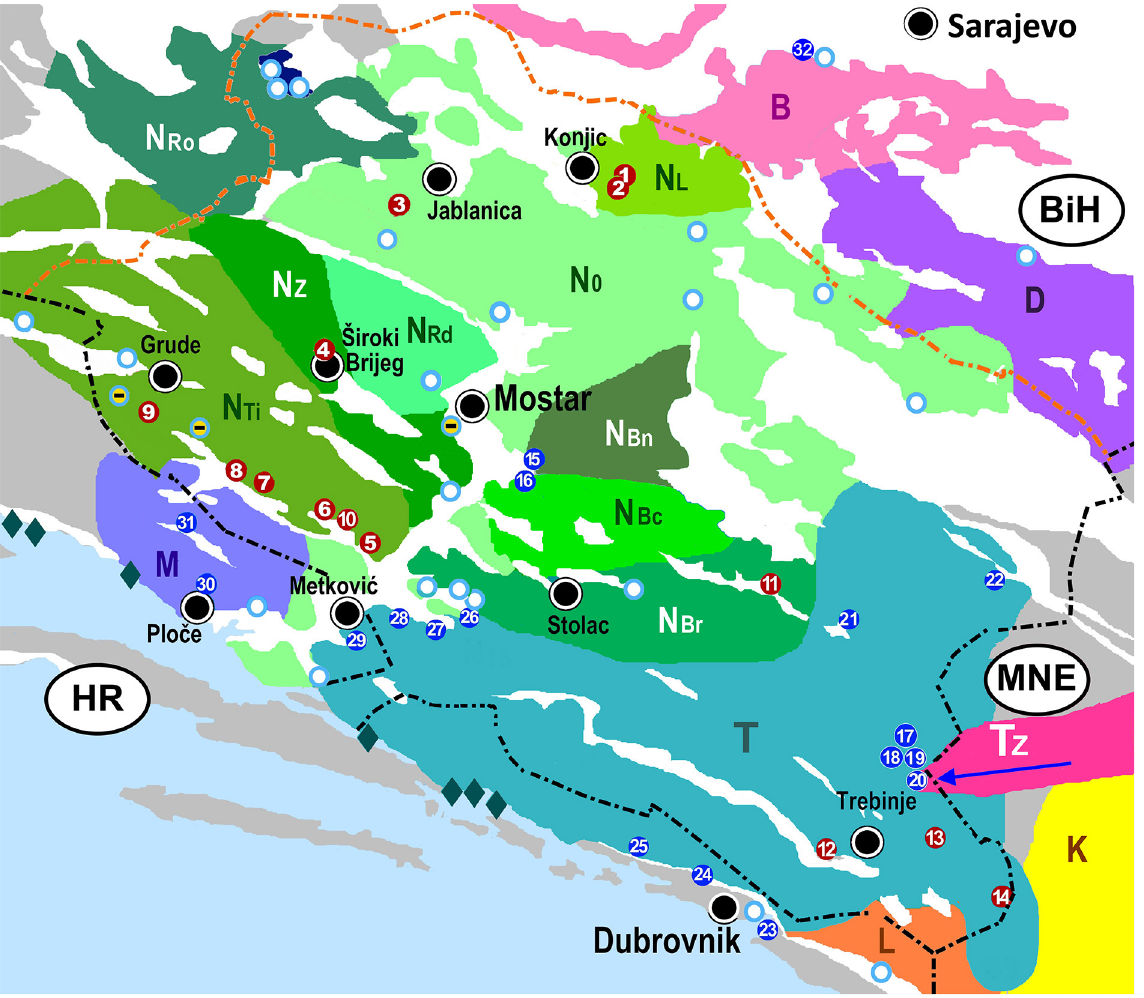
Fig. 17. Karst aquifers of Hercegovina and their estimated delimitations to drainage basins. As most to the karst aquifers in Hercegovina are represented by subterranean karst conduits, it is difficult to exactly set the watersheds. The subterranean drainage divides in this map were estimated based on our recent knowledge about the geology, hydrogeology and geomorphology. The boundaries are unstable and strongly dependent on a dynamic system of particular water level alternations in each perched water table within the basin as well as on their particular saturation. The interim oversaturation in the particular basin could lead to water divergence to the neighbouring river basin. The supposed inter-basin water divergences at high water saturation are highlighted by blue arrows. Each drainage basin could be further divided to separate subterranean karst conduits, which could also represent a kind of particularly isolated habitat. Freshwater springs are in circles and brackish or submarine spring are as diamonds with locality numbers according to the legend from Figure